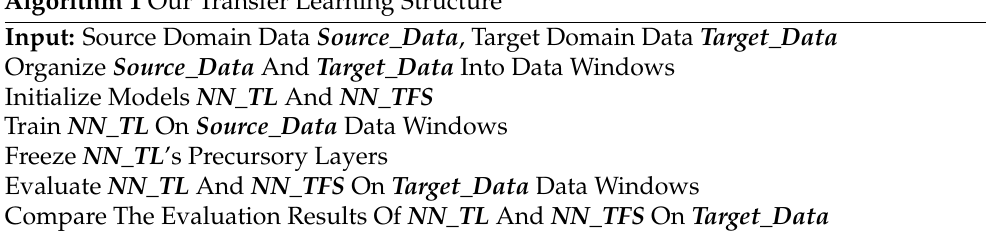
Algorithm 1 Our Transfer Learning